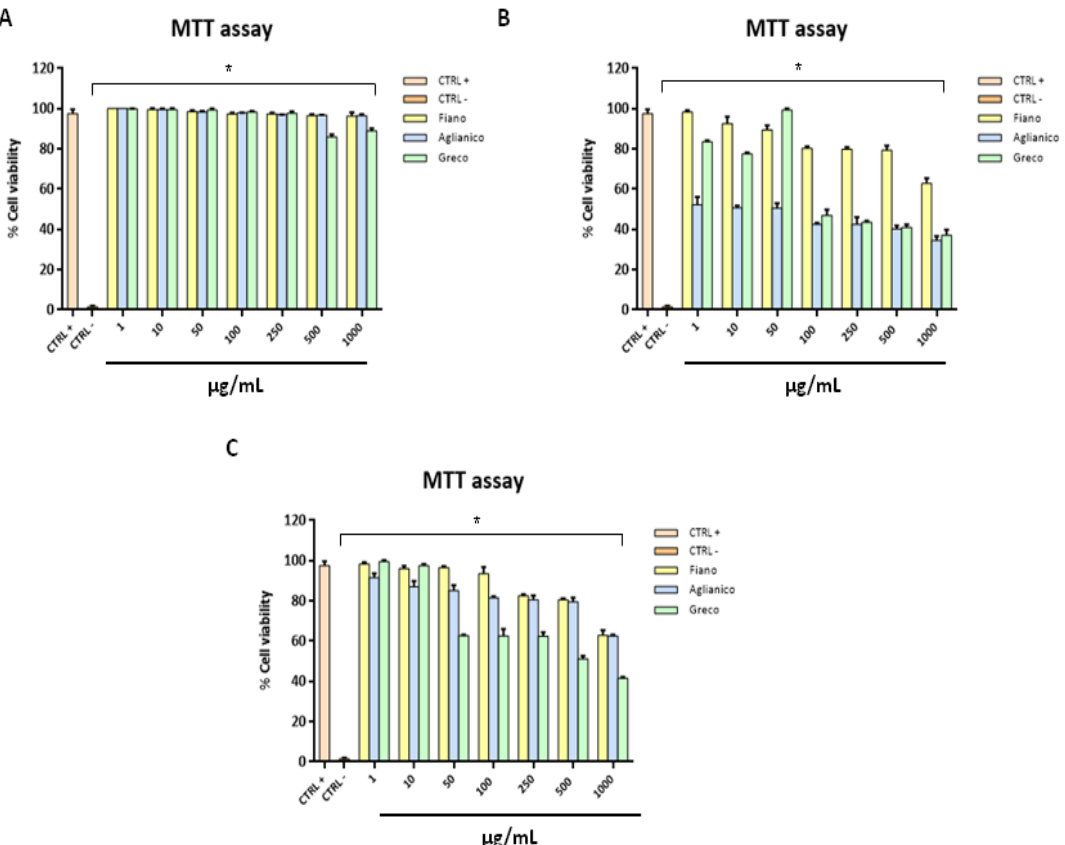
Figure 5. Cytotoxicity evaluation at different extraction pH. Cytotoxicity was assessed via MTT assay after 24 h post-treatment at pH 7.00 ( A ), 1.00 ( B ), and 13.00 ( C ). Statistical differences were evaluated via two-way ANOVA; a value of p ≤ 0.05 was considered significant, with * p ≤ 0.0001.